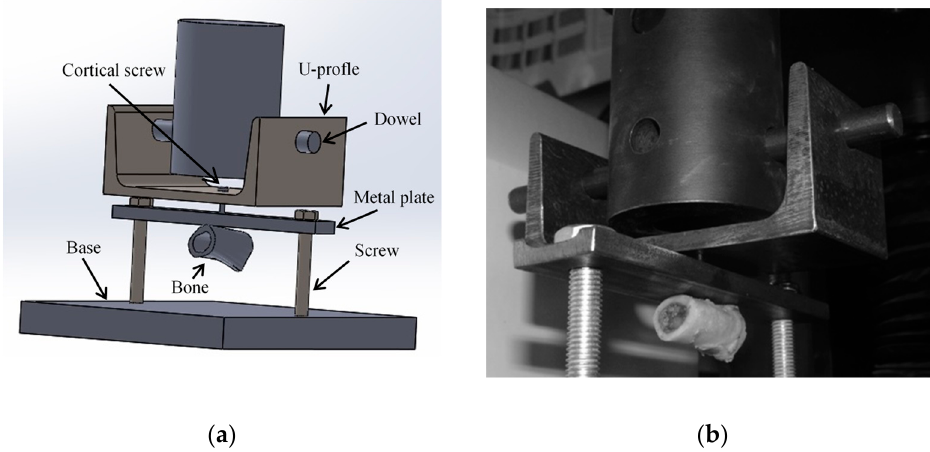
Figure 5. Schematic representation ( a ) and pull ‐ out strength test ( b ) in the goat cortical bone.